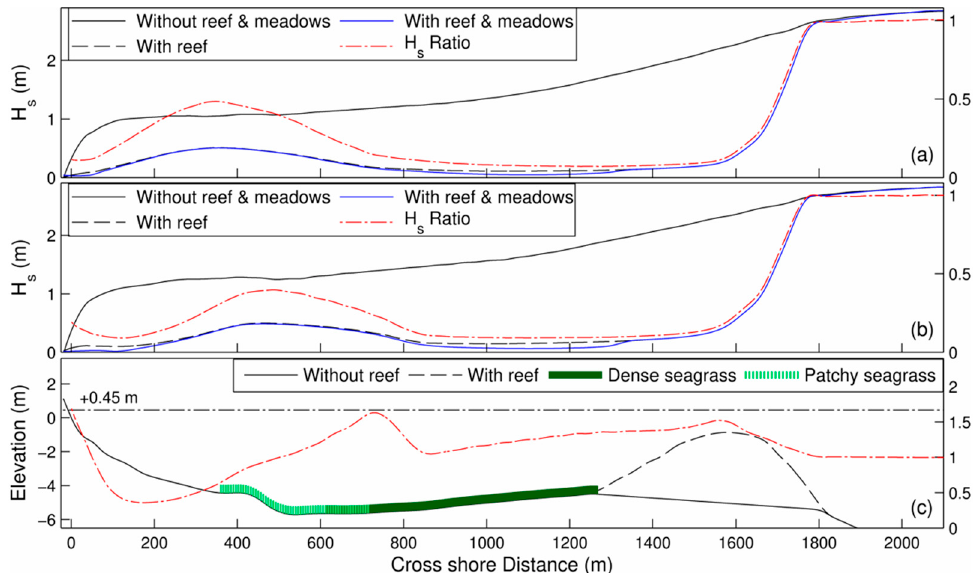
Figure 5. Effects of the shallow coral reef and of the combined reef and back-reef seagrasses on the present and future cross-shore distribution of wave height along a cross-shore profile (for profile location see Figure 2). ( a ) Cross-shore wave height and wave attenuation ratio (Hs ratio, scale at the right axis) due to observed ecosystems under the present mean sea level. ( b ) Cross-shore distribution of wave height and attenuation ratio under a 0.15 m MSLR coupled with spring tides (+0.3 m). ( c ) Bed profile and cross-shore distribution of the ratio of wave attenuation under an increased sea level (+0.45 m) and the present mean sea level (stippled line,Hs ratio (+0.4)5 /Hs ratio (0.0) , scale at the right axis). Offshore wave height and period modelled, Hrms = 2.8 m and Tp = 8.7 s, respectively. Median sediment size (D50), 0.28 mm. Dense seagrass characteristics as shoot density of 400/m 2 , canopy height of 0.20 m and grass diameter of 0.01 m; patchy seagrass characteristics as 200/m 2 , 0.20 m and 0.01 m, respectively (example from profile 40).